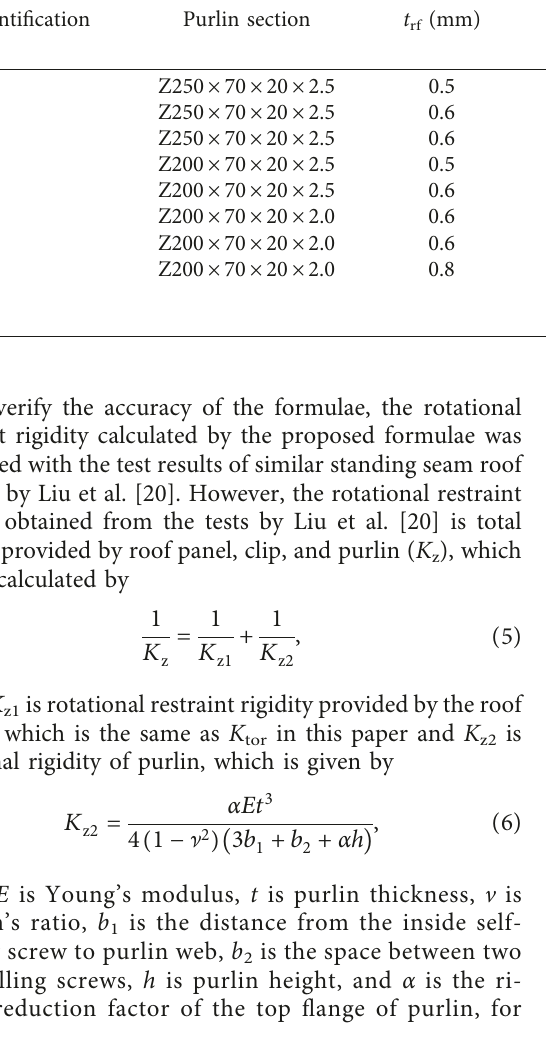
Table 2: Comparison of rotational restraint rigidity calculated by Equation (4) with test result by Liu et al. [20]. Test